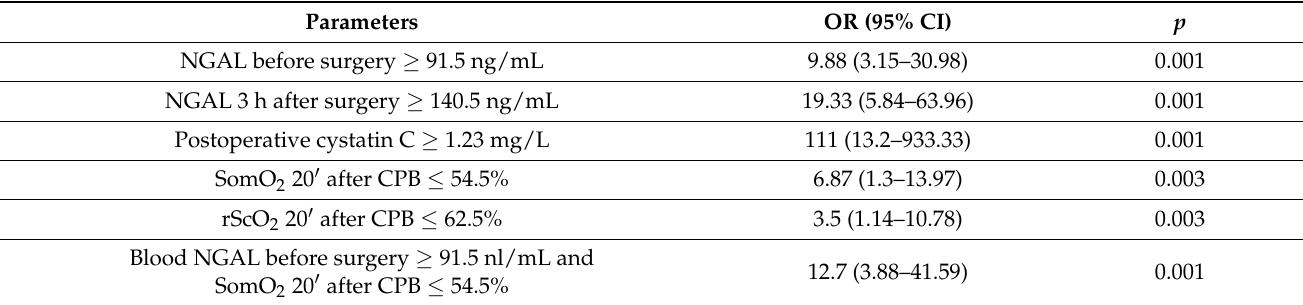
Table 3. Univariate logistic regression analyses for blood NGAL, cystatin, and NIRS cut-off values in CS-AKI prediction.